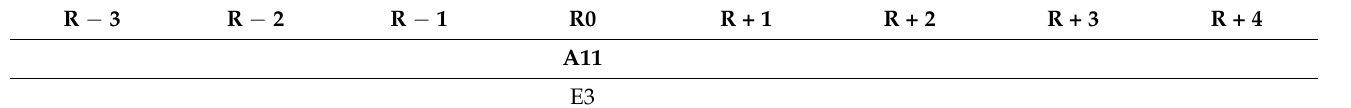
Table 2. Conditioned behavior associated with the clear expression of emotions (A11). R − 3 R −